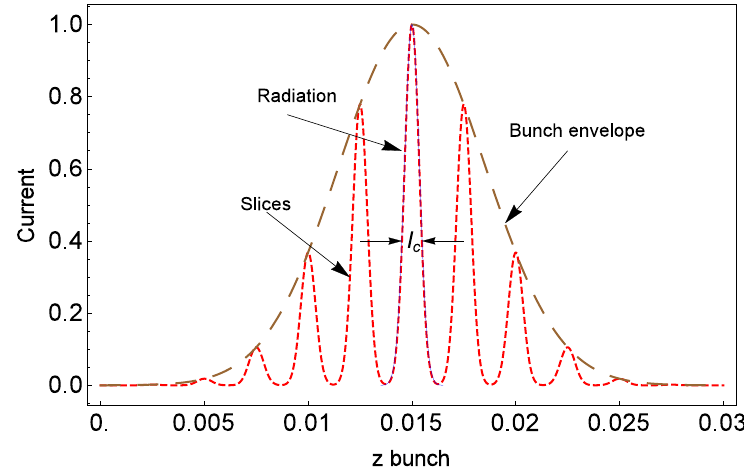
Figure 8. Bunched envelope, associated slices and superimposed